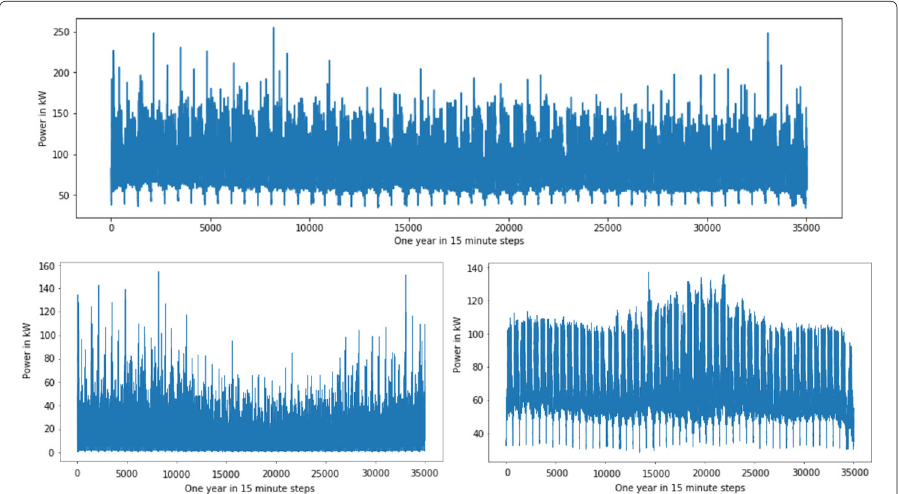
Fig. 4 The total load is shown in the top. In the bottom left, the aggregated residential load is shown and in the bottom right, the aggregated commercial load is shown. All data have a 15-min